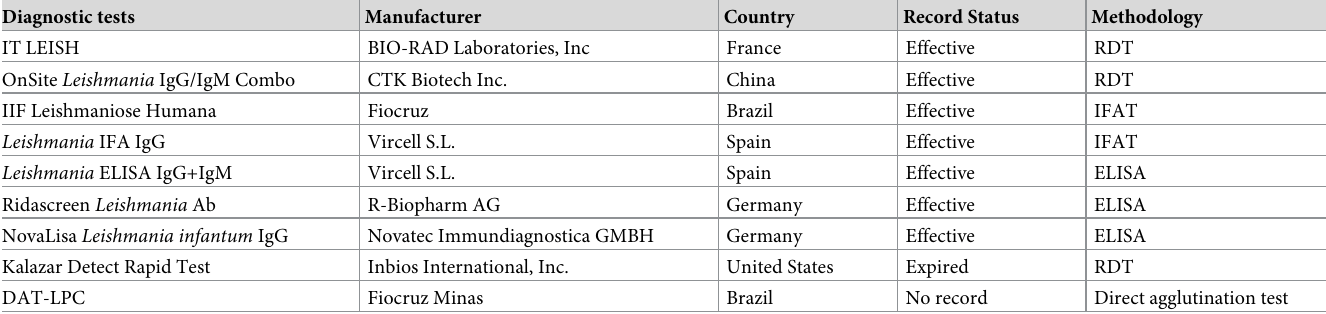
Table 1. Diagnostic kits for human visceral leishmaniasis included in the